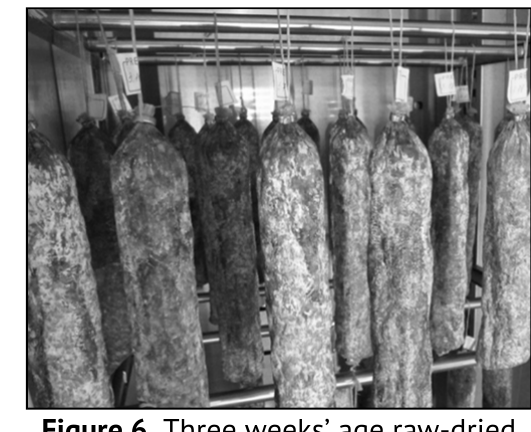
Figure 6. Three weeks’ age raw-dried